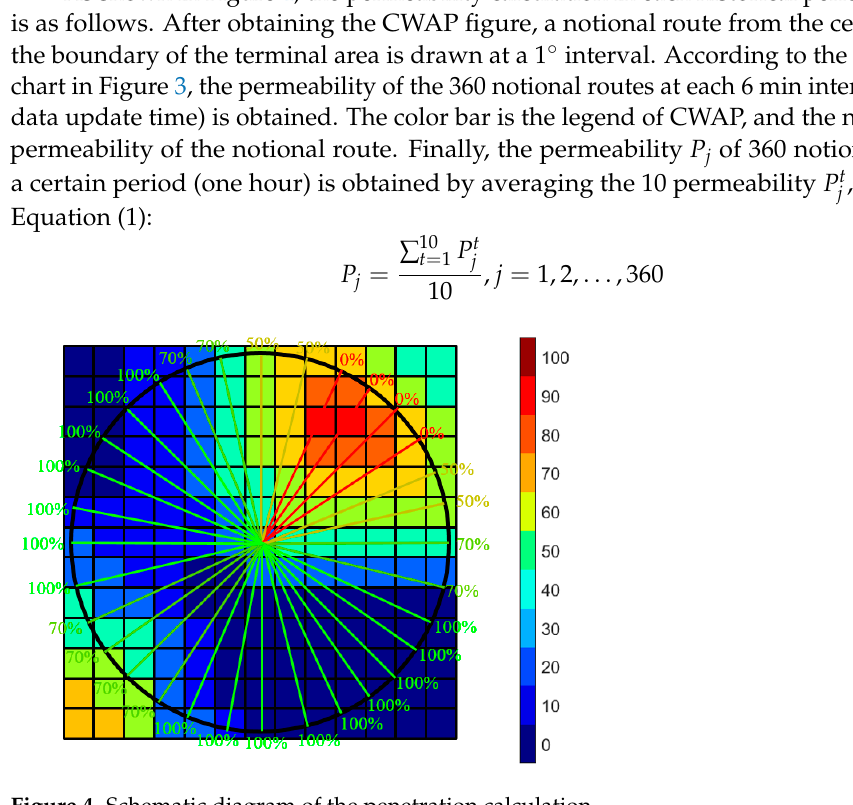
Figure 3. The calculation process of the permeability chart.